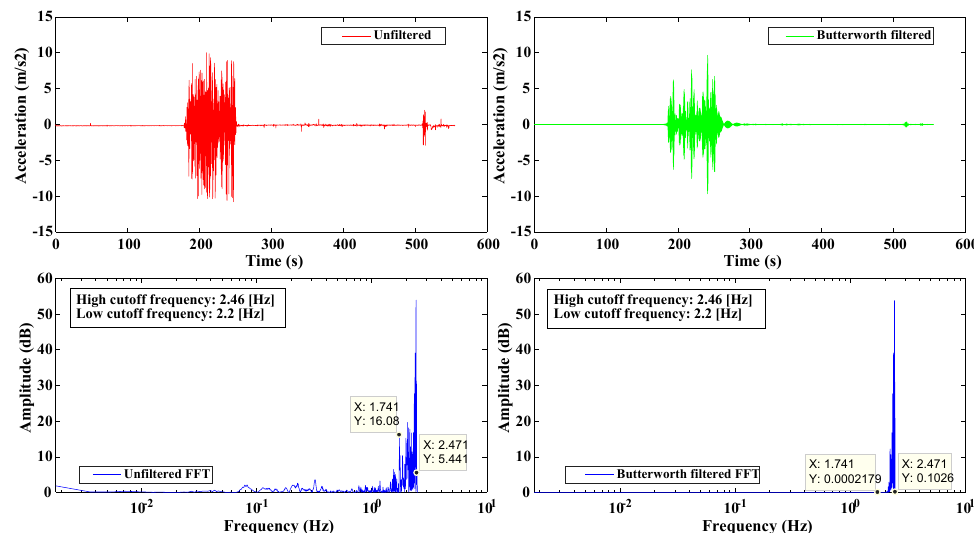
Figure 6. Fast Fourier spectrum of unfiltered and Butterworth filtered acceleration signals.